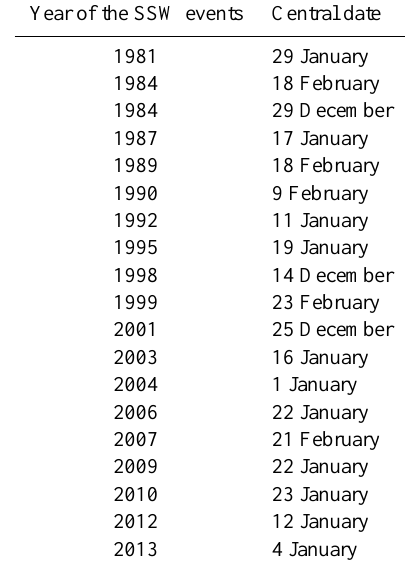
Table 1. Central date of the identified SSW